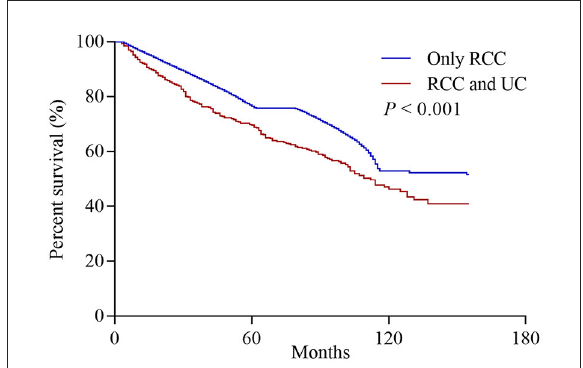
FIGURE1 Overall survival of patients who initially presented with solitary renal cell carcinoma (RCC) or synchronous concurrent RCC and urothelial carcinomas (UC).